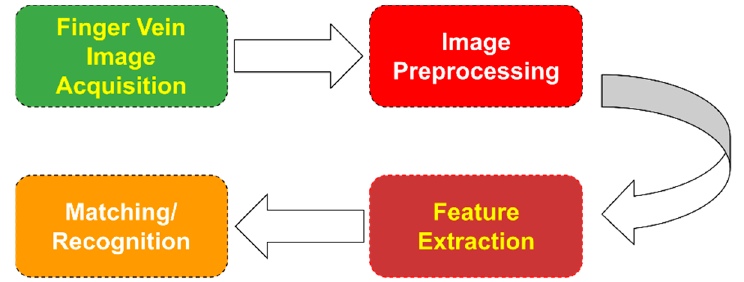
Figure 1. Finger vein feature extraction Figure 1 . Finger vein feature extraction flowchart .